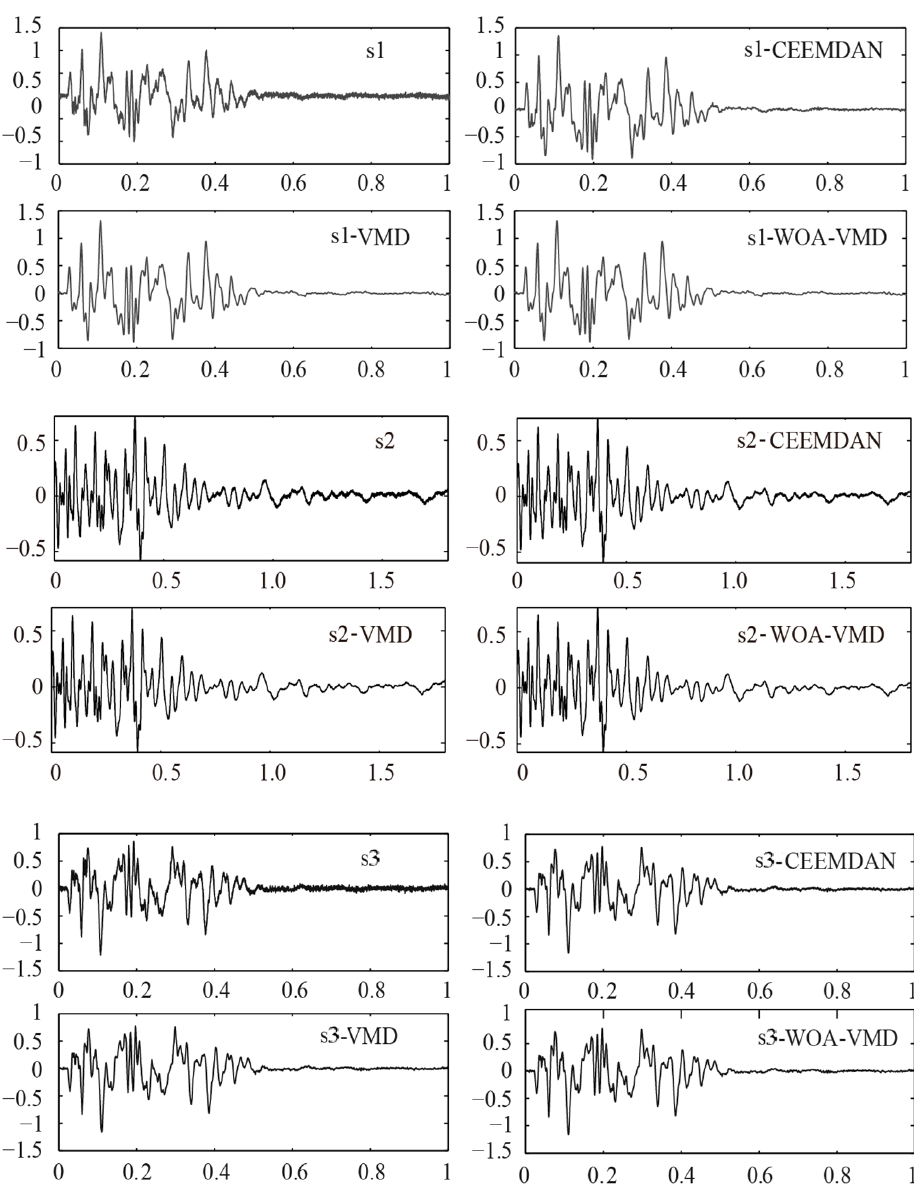
Figure 6. Comparison between original signals and denoised signals.